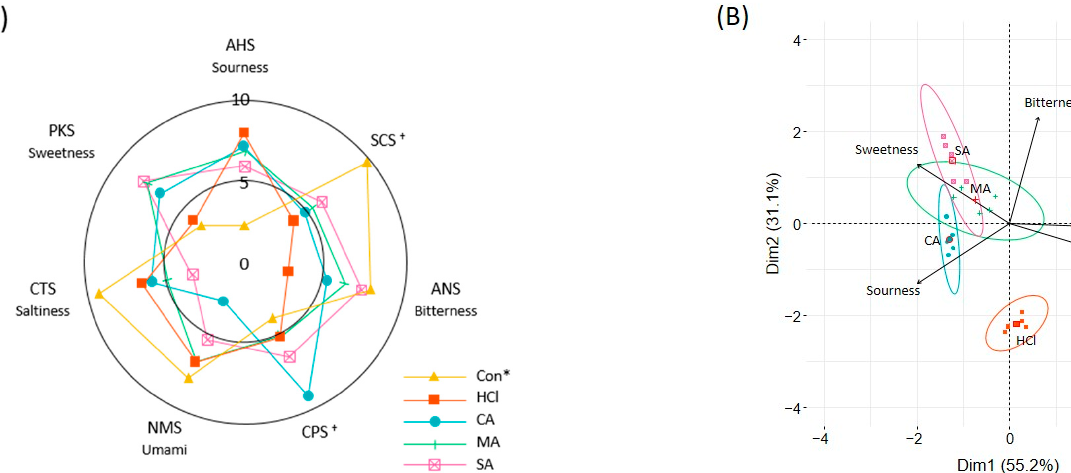
Figure 4. The effect of organic acid on the taste profile of enzymatic protein hydrolysate ( A ) and the relationship between organic acid and taste profile by principal component analysis ( B ). Data are expressed as the mean ± SD of five samples. * Con, without any acids; HCl, hydrochloric acid; CA, citric acid; MA, malic acid; SA, succinic acid. † Reference sensors.